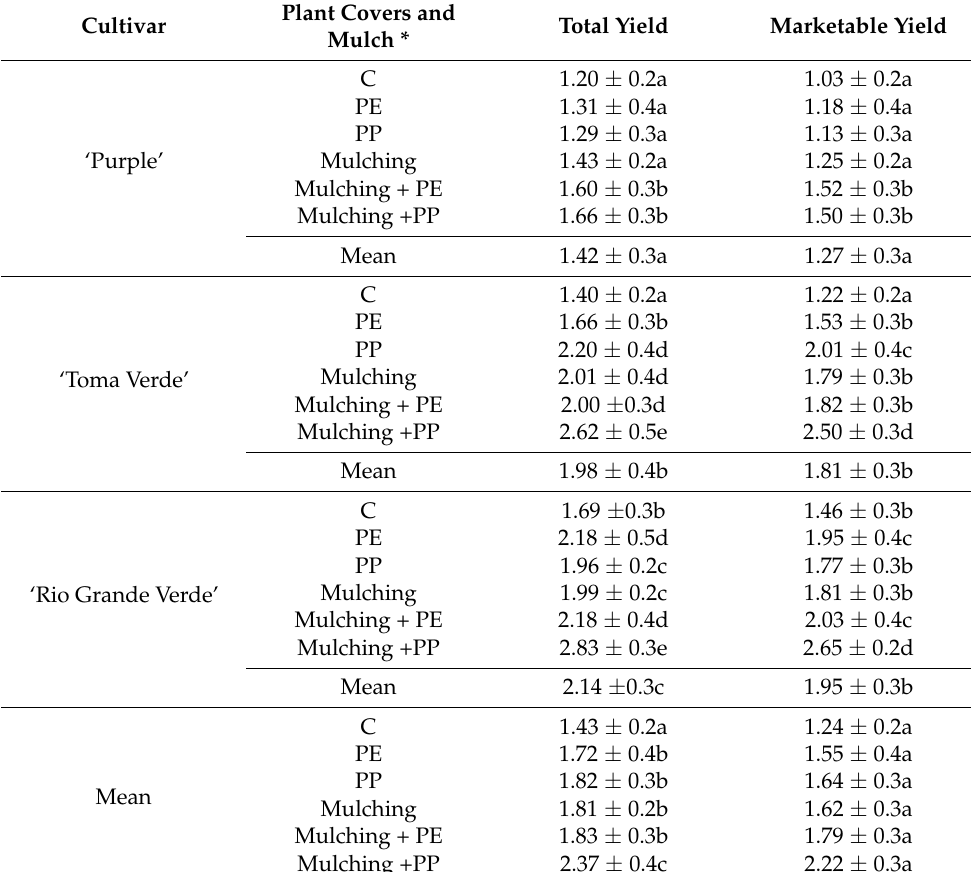
Table 10. The effects of cultivar, plant covers and mulching on the total tomatillo fruit yield (kg·m − 2 ) (means of 2015, 2017–2018).